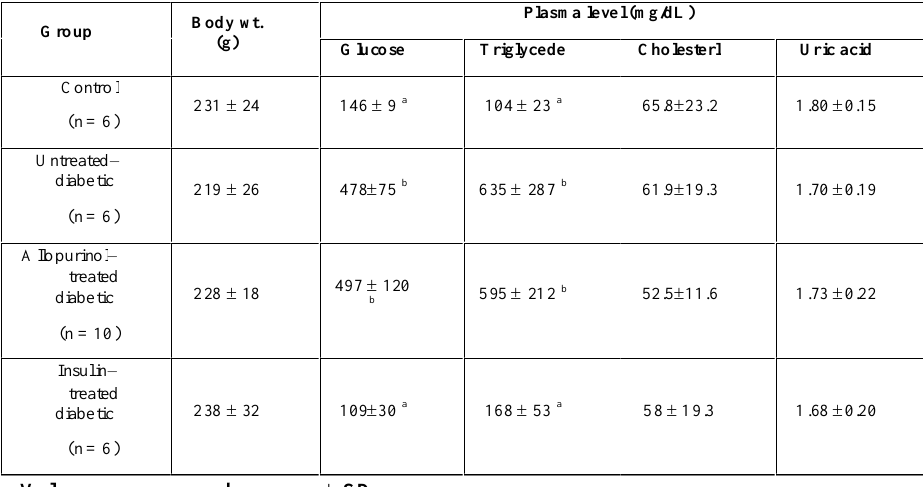
Table 2: Body weight and biochemical parameters in control, untreated – ALX diabetic, allopurinol – treated – ALX diabetic, and insulin treated – ALX diabetic rats. Group